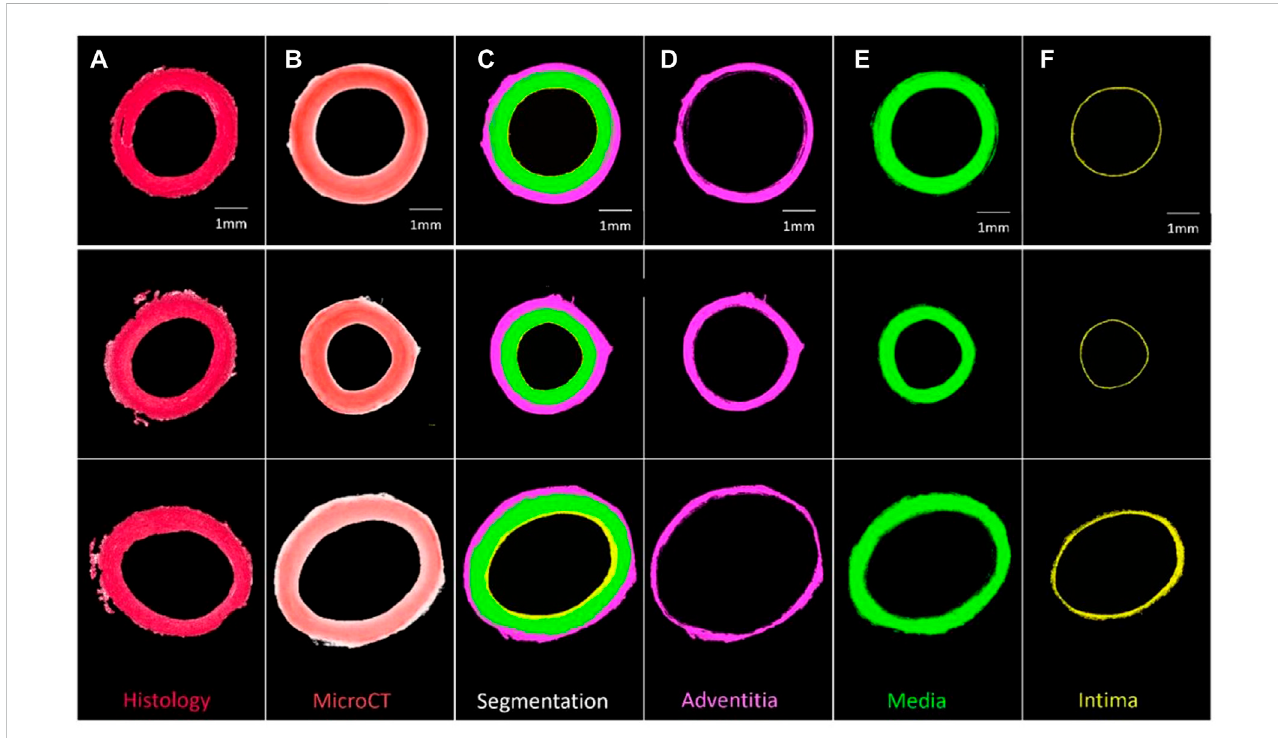
FIGURE 3 SegmentationofthreePTA-stainedporcinecarotidarterysamplesintotheirrespectivelayers (A) HistologicalPSRimage, (B) PTAstainedMicroCTimage, (C) Segmentation, (D) Adventitia, (E) Media, and (F)